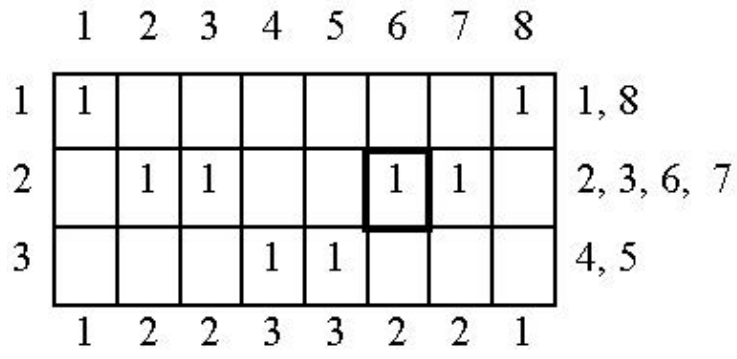
Figure 8. An example for set A w and B j calculation.